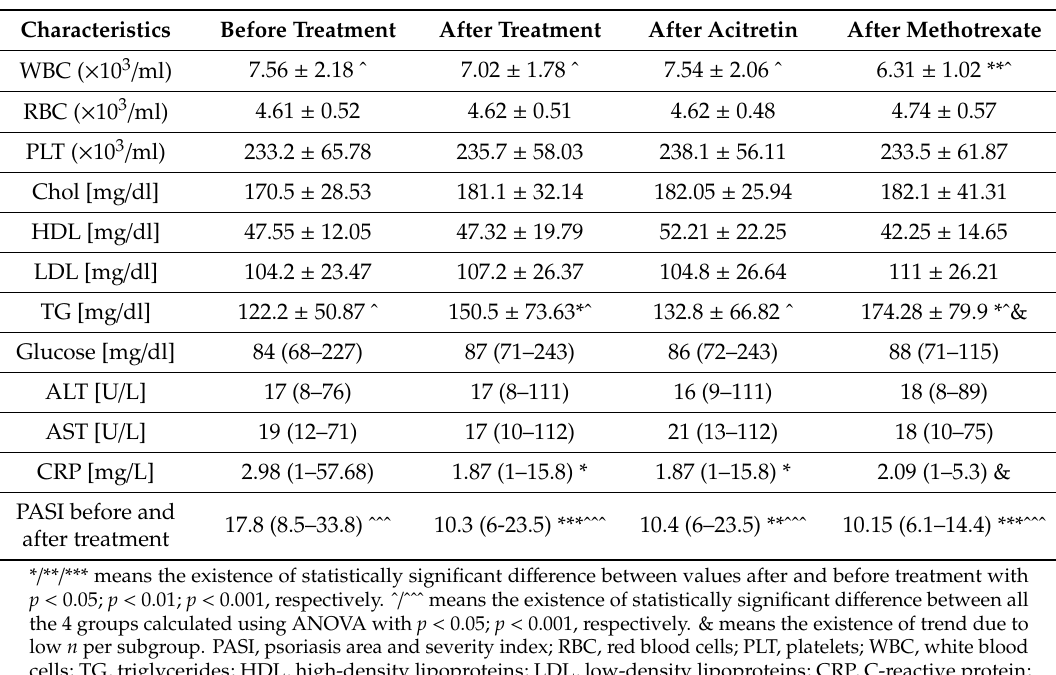
Table 2. Basal characteristic of the patient group before and after treatment in total and separately with both drugs. (Before treatment: n = 33, after treatment: n = 33, ACY: n = 19, MTX: n = 14). Characteristics Before Treatment After Treatment After Acitretin After Methotrexate ALT [U/L] WBC ( × 10 3 / ml)